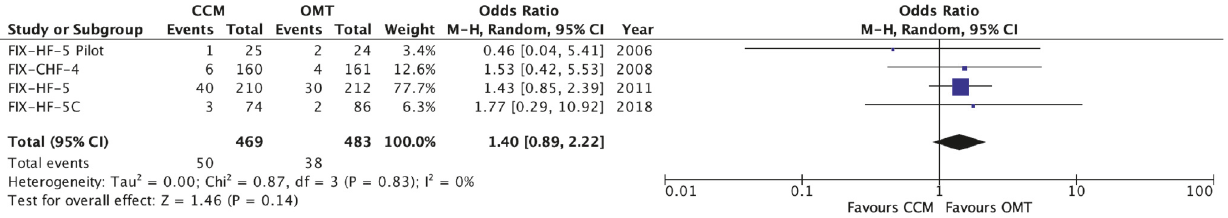
Figure 5: Forest plot of cardiac arrhythmias in CCM groups versus the control groups. A forest plot of the data available to us from the 4 RCTs assessing arrhythmias in those with CCMcompared to those with OMT alone. Therewas a nonsignificant trend in reduced arrhythmic events favoring the OMT